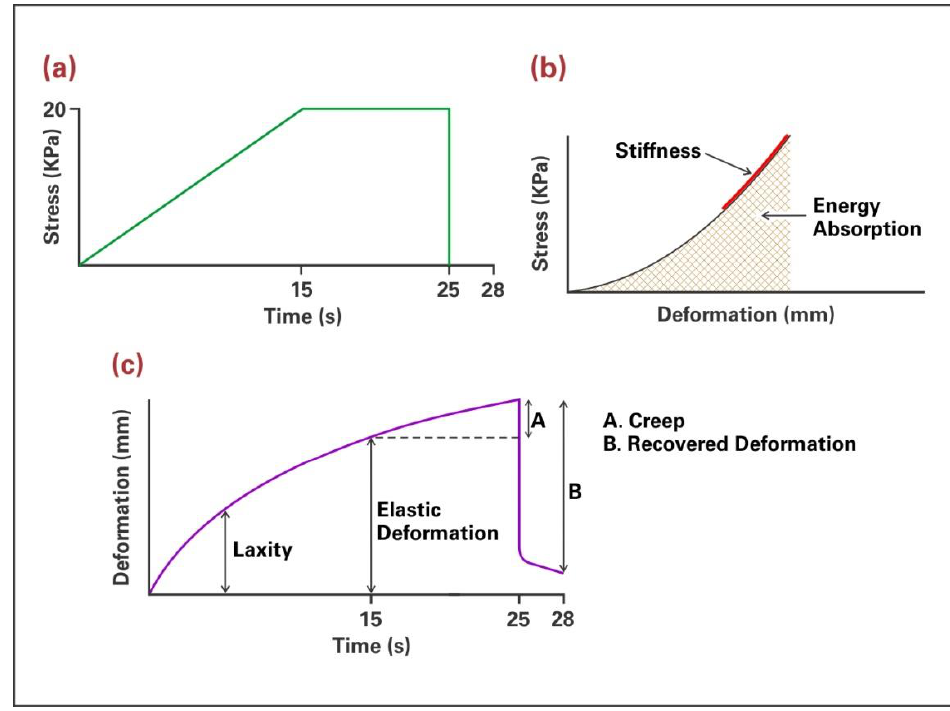
Figure 2. ( a ) Stress-time plot showing loading regimen of applied vacuum. ( b ) Stress-deformation plot showing stiffness measured as the slope of the straight-line portion and energy measured as the area under the plot. ( c ) Deformation-time plot with laxity measured as initial deformation produced by low stress, elastic deformation being the deformation accumulated at the end of vacuum application, creep (A) representing viscous deformation occurring while vacuum is held constant and recovered deformation (B) as the amount of deformation recovered over 3 s following vacuum release. Percent laxity is calculated as laxity divided by elastic deformation times 100. Percent elasticity is calculated as recovered deformation divided by elastic deformation times 100.